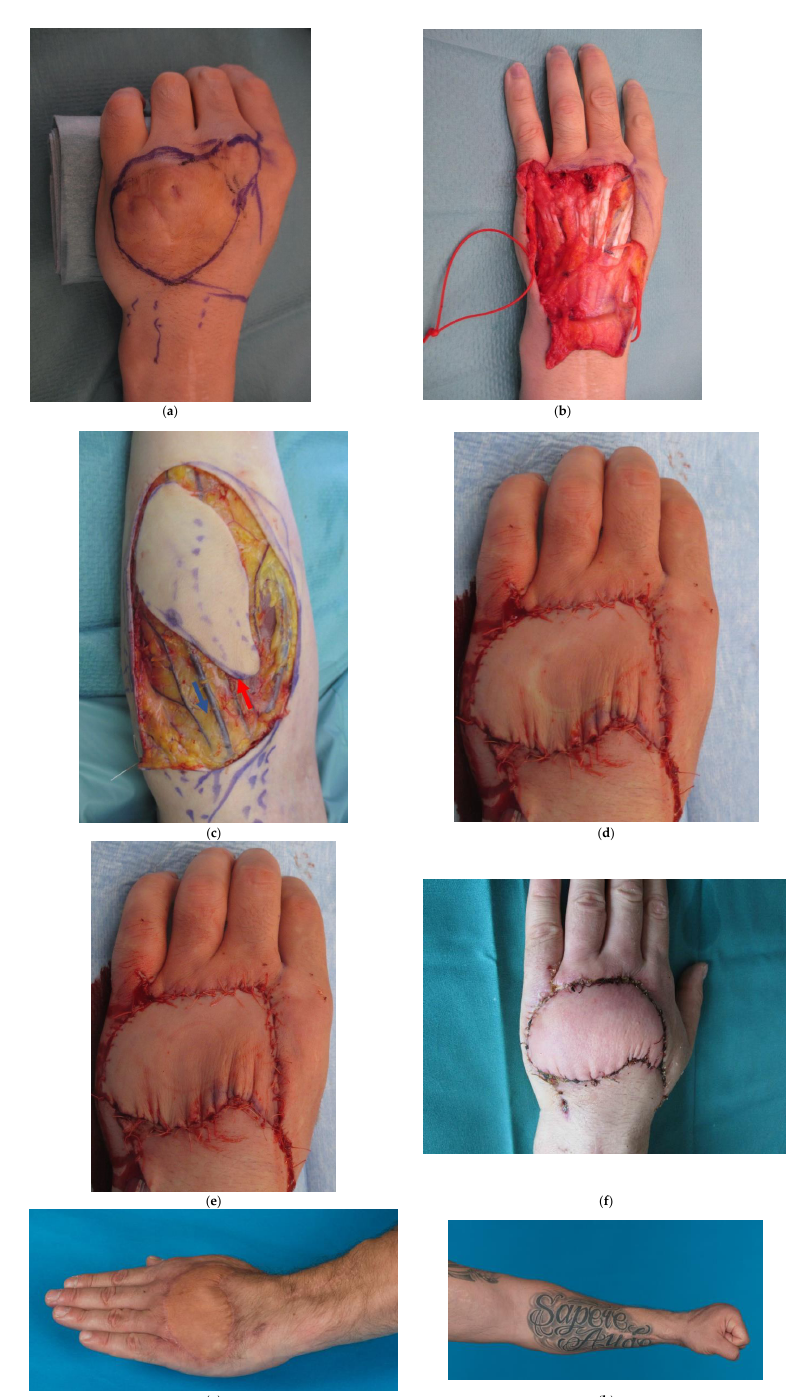
Figure 1. ( a ) In the retrograde free venous flaps, the input arterial flow (red arrow) is entering the flap through a vein against the valve; ( b ) In this case, more detailed in Figure 2, the flap was studied upside down with ICG green to document the revascularization pattern once the artery and the draining vein were sutured; ( c ) the same flap at time 0, when the ICG started flowing into the arte- rialized vein; ( d ) The flap after 5 min with diffuse revascularization. The strong stream signal in the centre is a leak from the arterialized vein.